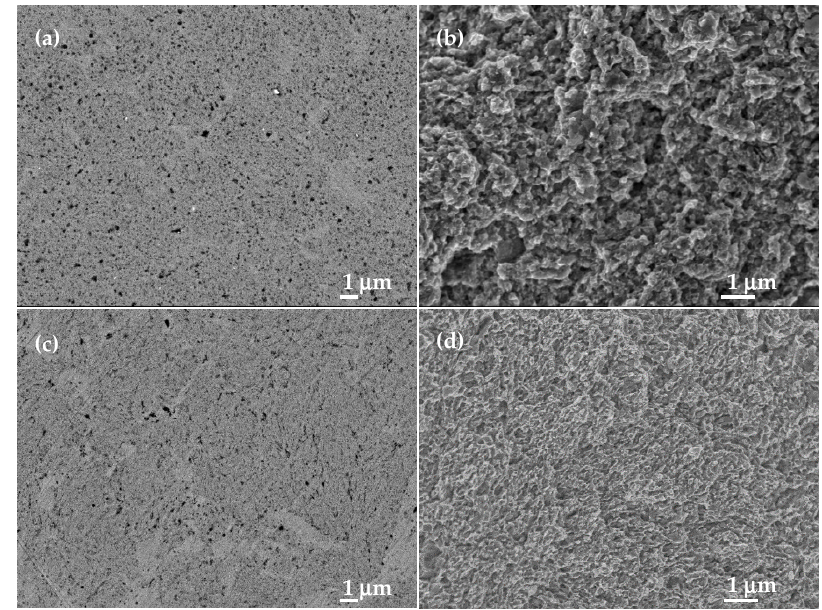
Figure 4. Ex-situ nanocomposite Cu-TiC (5 vol. % TiC) sintered at 700 °C ( a ) polished surface; and ( b ) fractured surface; in-situ nanocomposite Cu-TiH2-C (5 vol. % TiC) sintered at 950 °C; ( c ) polished surface and ( d ) fractured surface.